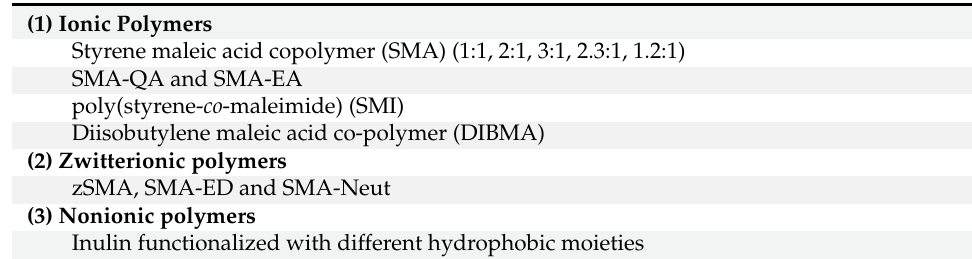
Table 3. List of synthetic amphipathic polymers used for detergent-free isolation of membrane proteins directly from the cell